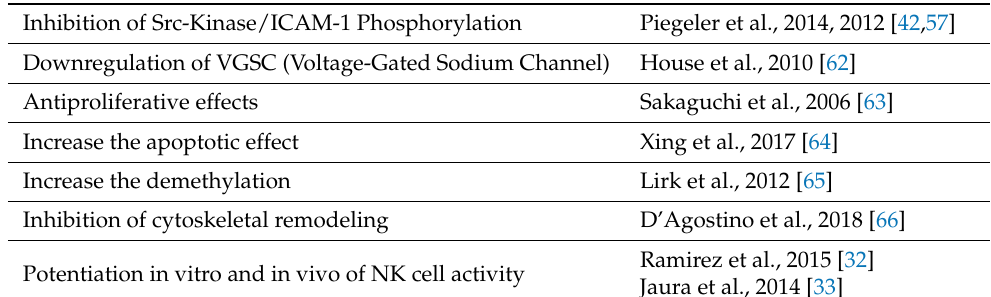
Table 2. Biomolecular Mechanisms and Antimetastatic Properties of Amide-Type Local Anesthetics. Inhibition of Src-Kinase/ICAM-1 Phosphorylation Downregulation of VGSC (Voltage-Gated Sodium